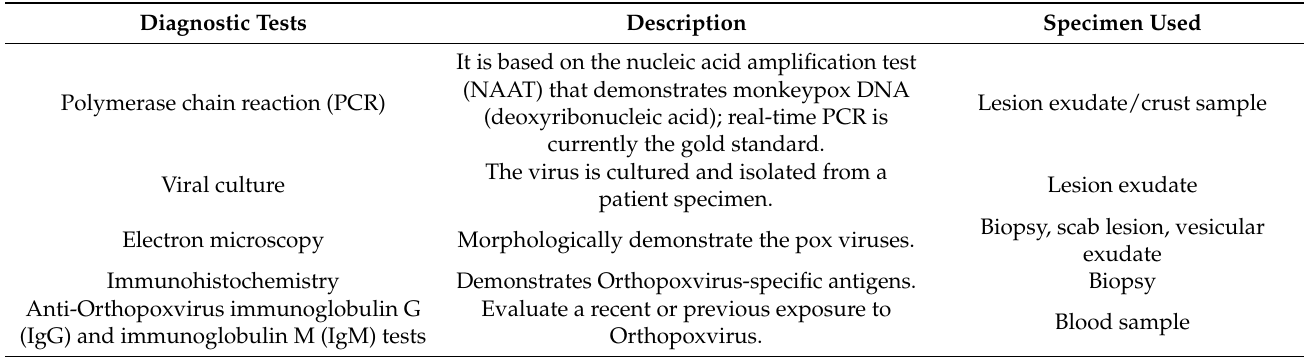
Table 1. Delineates the various diagnostic aids for monkeypox virus